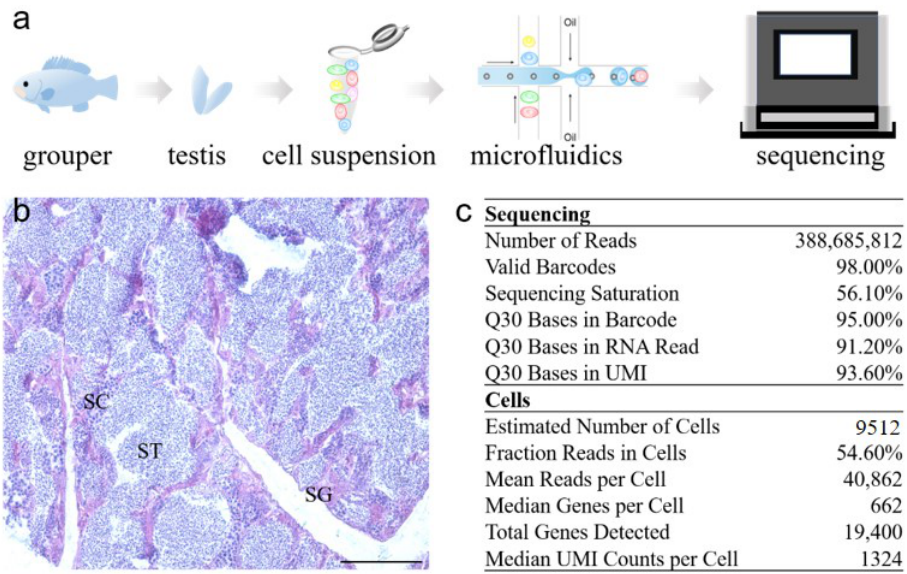
Figure 1. Overview of scRNA-seq experiment design and statistics. ( a ) The workflow of the whole experiment. A male, orange-spotted grouper was obtained, and then the gonad was sampled. Part of the gonad was prepared into single-cell suspension, then every cell was packaged to a single microsphere for subsequent scRNA-seq. ( b ) Gonadal histological morphology of the male grouper by H&E staining. Scale bar = 50 µ m. ( c ) The basic information of scRNA-seq data. SG, spermatogonium; SC, spermatocyte; ST,